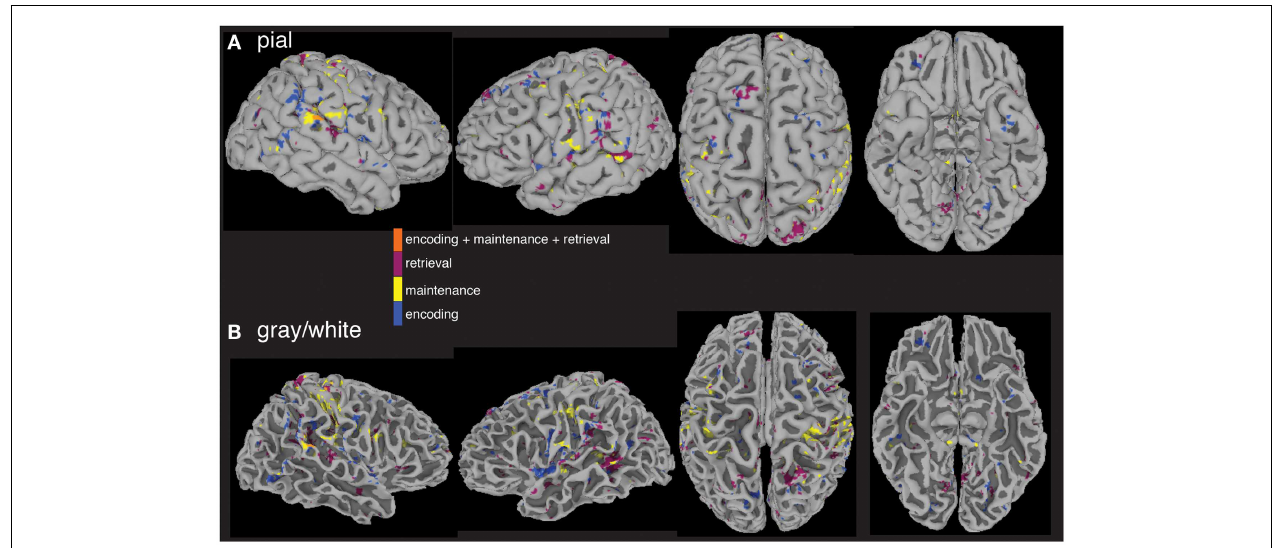
FIGURE 6 | Between-group fMRI activity differences masked by age and accuracy covariate interactions .When significant age and accuracy interaction differences are subtracted from the between-group analysis, widespread regional increases ( p < 0.05) in activity in patients vs. controls across all three task periods remain. Masked differences are shown on a pial (A) and gray/white border (B) surface reconstruction of theTT_N27 brain in MNI